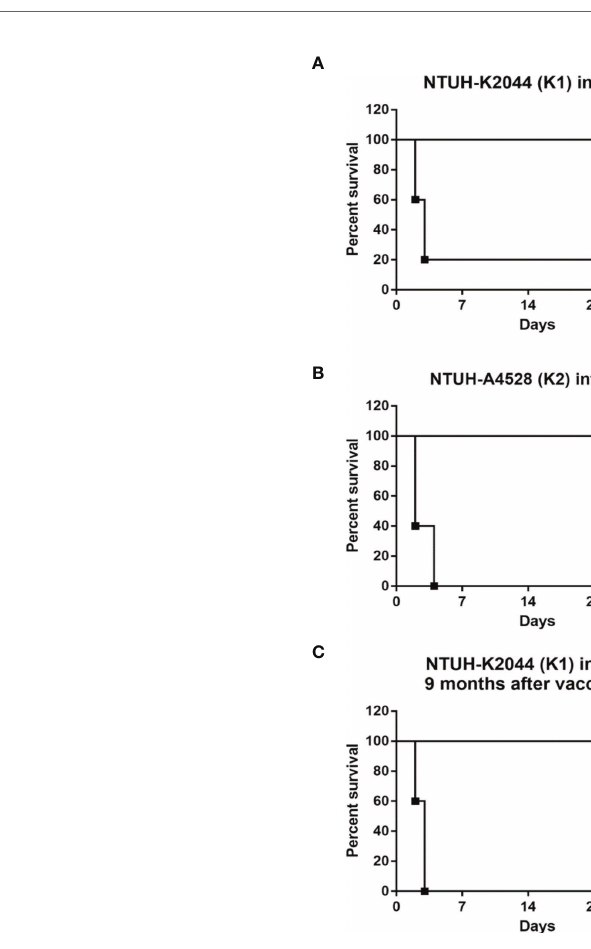
FIGURE 7 | The ef fi cacy of K1 or K2 CPS-conjugated vaccine in the mouse model. Mice ( fi ve per group) immunized with K1 or K2 CPS-conjugated vaccine were challenged by IP injections of 1×10 4 CFU of K. pneumoniae NTUH-K2044 (A) or NTUH-A4528 (B) per mouse. Vaccination with K1 or K2 CPS-conjugated vaccine signi fi cantly increased the survival rate of mice that were challenged by infection of K. pneumoniae NTUH-K2044 ( P =0.0144, log-rank test) or NTUH-A4528 ( P =0.0023, log-rank test), respectively. (C) Mice ( fi ve per group) immunized with K1 CPS-conjugated vaccine were challenged by IP injections of 1×10 4 CFU of K. pneumoniae NTUH-K2044 per mouse after nine months. And the results showed that the vaccination with K1 CPS-conjugated vaccine from 9 months ago still signi fi cantly increased the survival rate of mice that were challenged by infection of K. pneumoniae NTUH-K2044 ( P = 0.0031, log-rank test). Both groups were protected from pyogenic liver abscess and